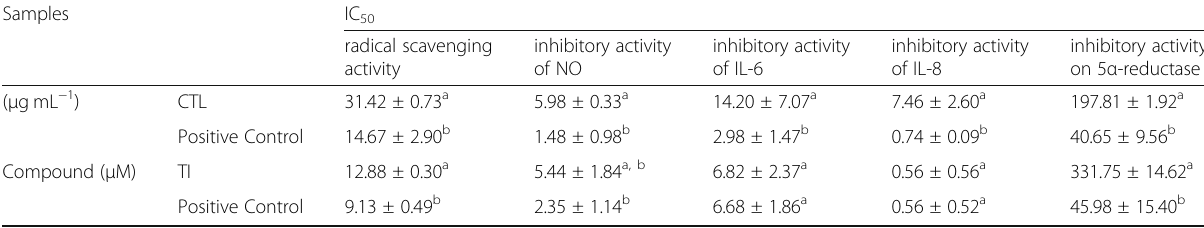
Table 1 IC 50 values of Carpinus tschonoskii leaf (CTL) extract and tellimagrandin I (TI) on each bioactivity, including free radical scavenging activity, inhibitory activity of NO production, IL-6, IL-8 and 5 α -reductase